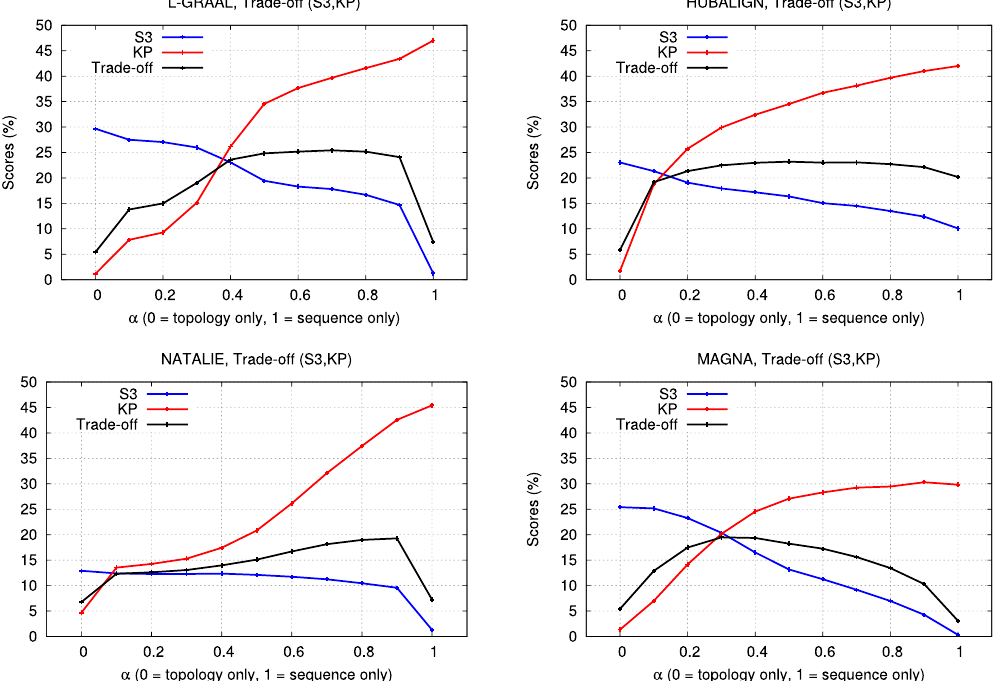
Figure 4. Effects of using topology and sequence homology. For L-GRAAL (top-left panel), HUBALIGN (top- right panel), NATALIE (bottom-left panel) and MAGNA (bottom-right panel), we report the average quality of the alignments that they produce on our 16 PPI network pairs, when aligning PPI networks by using topological information only ( α = 0, on the left on the x-axis), sequence similarity only ( α = 1, on the right on the x-axis) and their combinations (all α in between in increments of 0.1). The qualities of the alignments are measured with topological score S 3 (blue curves), biological score KP (red curves) and the trade-off score between biological and topological quality (black